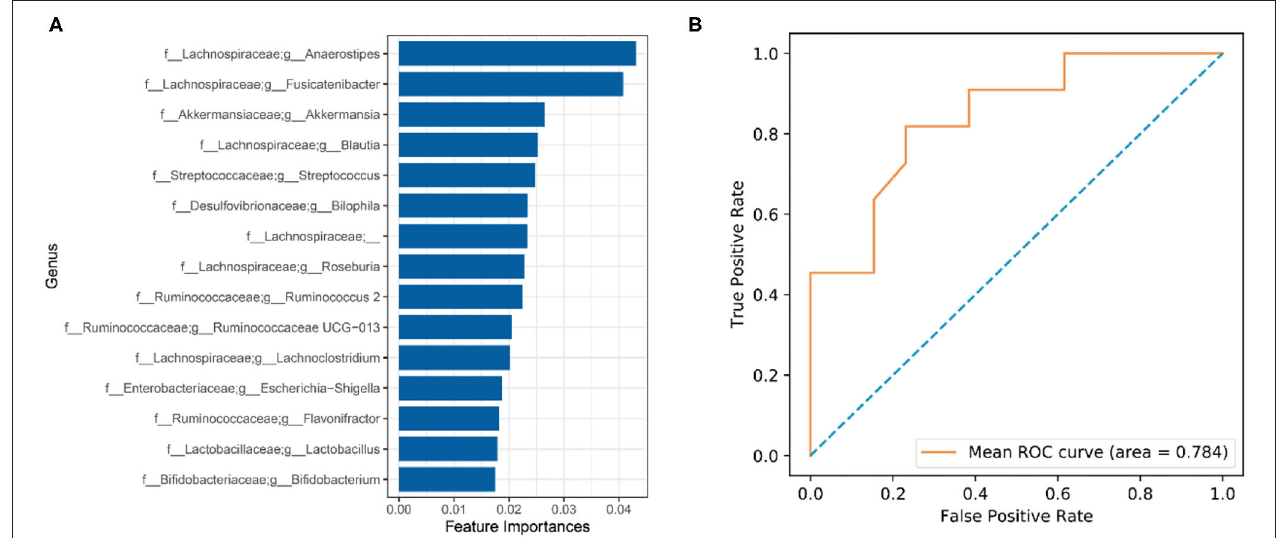
FIGURE 6 | Identification of gut microbial markers for CI by random forest model. (A) Microbial markers were predicated using a random forest model. (B) ROC curve